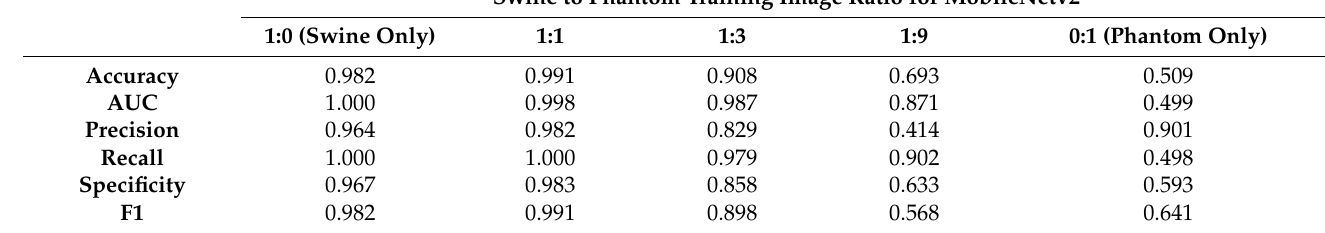
Figure 7. Swine-Phantom Hybrid Training Results with MobileNetv2 for Shrapnel Image Classification. Confusion matrices and ROC analyses for swine image prediction after training with image sets augmented with ( A ) 1:0, ( B ) 0:1, ( C ) 1:1, ( D ) 1:3, or ( E ) 1:9 swine: phantom ratios. The diagonal black dashed line in the ROC plots represents the result for random chance (AUC = 0.50) for reference. Table 4. Summary of MobileNetv2 model performance metrics for each training situation. Results are shown for a single training run for each ratio.